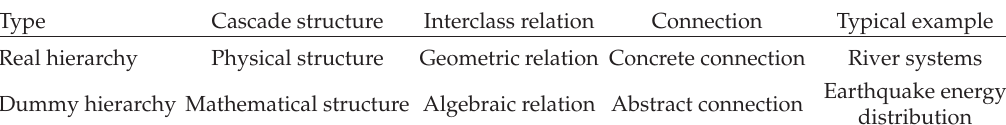
Table 2: Di ff erences between two typical types of hierarchies with cascade